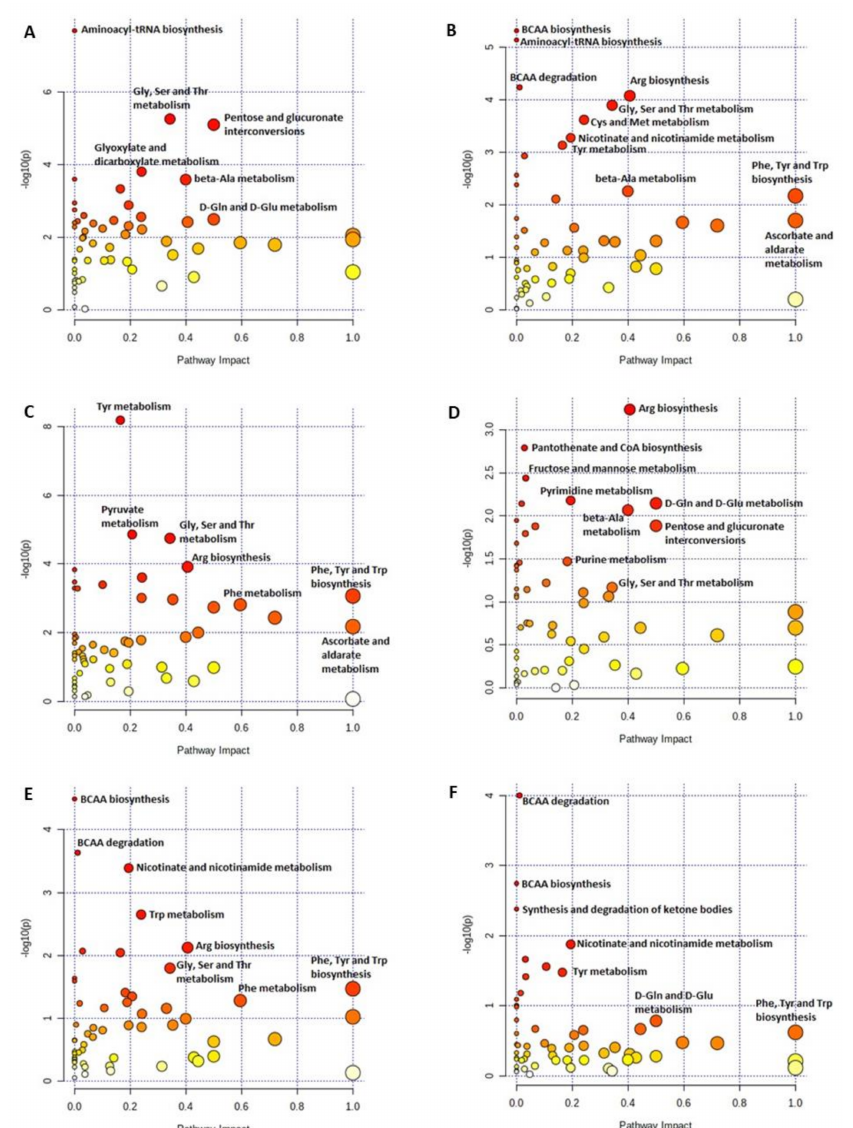
Figure 9. Pathway analysis map of plasma metabolites in nursery pigs fed with very-low-protein diets supplemented with Ile, Val, or combination of both. ( A ) LP vs. PC, ( B ) LPV vs. PC, ( C ) LPVI vs. PC, ( D ) LPV vs. LP, ( E ) LPVI vs. LP, and ( F ) LPVI vs. LPV. PC (positive control): standard-protein diet; LP (negative control): low-protein diet containing limiting amino acids (i.e., Lys, Met, Thr and Trp) at NRC (2012) levels; LPV: LP containing Val at NRC level; LPI: LP containing Ile at NRC level; LPVI: LP containing Val and Ile at NRC levels. Each circle is obtained from topology analysis representing a metabolic pathway with the scores. The x -axis indicates the pathway impact, and the y -axis shows the pathway enrichment. The circle size depends on its impact while its color is based on its p value (i.e., greater circle size shows higher pathway impact, while darker color circles demonstrate more significant changes of metabolites and pathway enrichment). n =